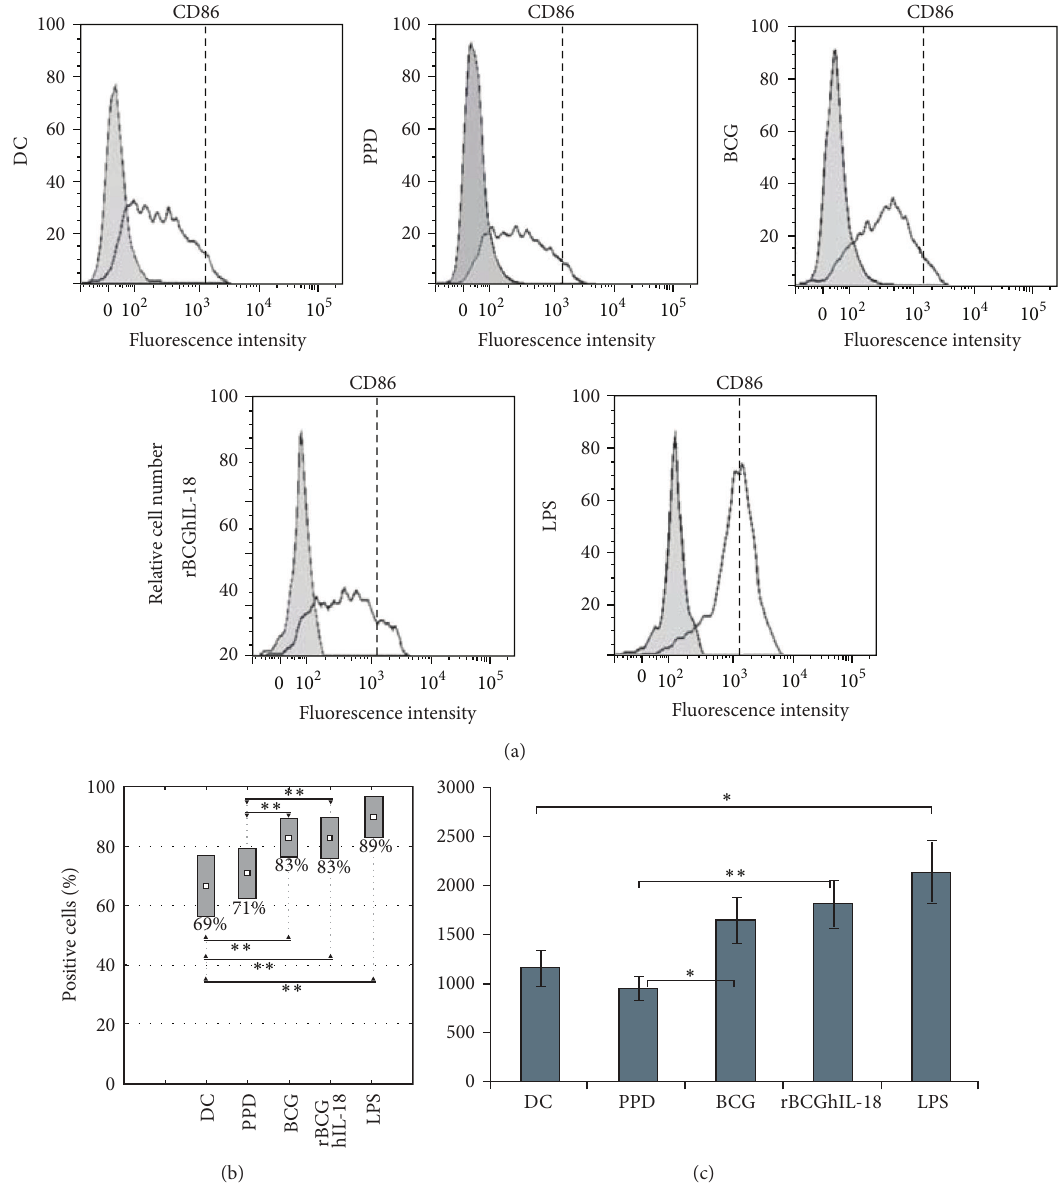
Figure 3: CD86 surface expression of MoDCs. Human MoDCs were pulsed either with PPD (10 𝜇 g/mL), BCG (1:1), rBCGhIL-18 (1:1), or LPS (1 𝜇 g/mL) for 24 h or were left unstimulated (DC). (a) One representative experiment out of 20 independent ones is shown. Grey histograms represent the cell reactivity to fluorochrome-matched isotype control antibodies. The white histograms represent the reactivity with the anti-CD86 antibody. The vertical broken lines represent the upregulation obtained by LPS stimulation; (b) percentage of positive cells with the CD86 expression; (c) median fluorescence intensity (MFI) values (median ± SEM of 20 independent donors). Fluorescence intensity was calculated by the MFI of the receptor expression from which the MFI obtained with a nonrelevant, isotype-matched antibody was substracted. Statistical analyses were performed using the Kruskal-Wallis test. ∗ 𝑃 < 0.05 ; ∗∗ 𝑃 < 0.01